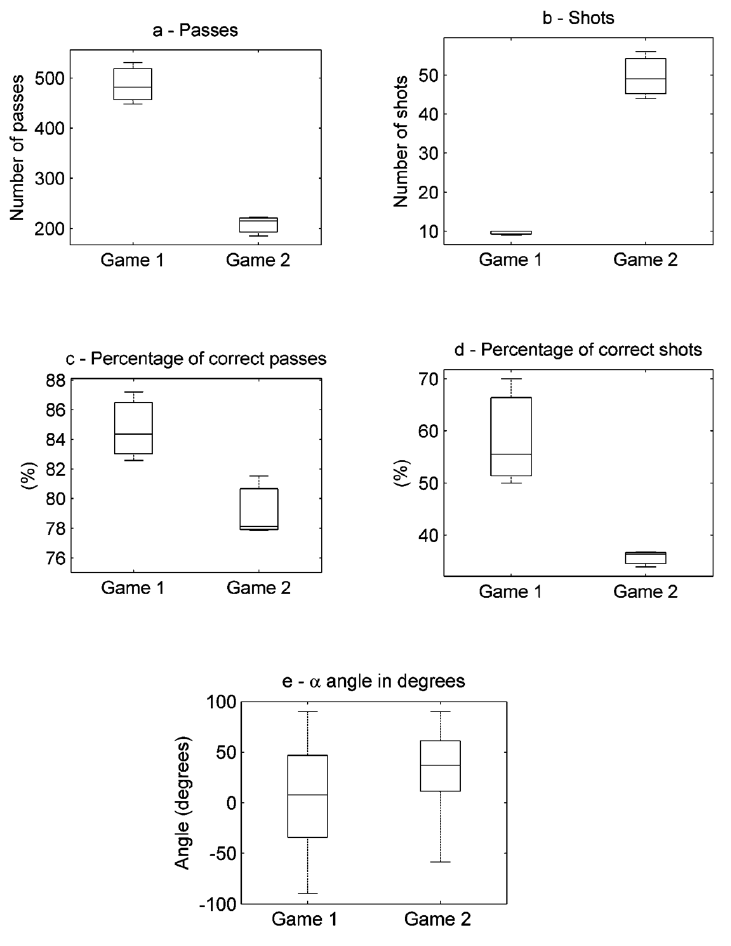
Figure 2. Box plot of the number of passes that occurred in Games 1 and 2 (a); Box plot of the number of shots that occurred in Games 1 and 2 (b); Box plot of the correct passes percentage in Games 1 and 2 (c); Box plot of the correct shots percentage in Games 1 and 2 (d); Box plot of the α angle, measured in degrees, of exchanged possessions of the ball during Games 1 and 2